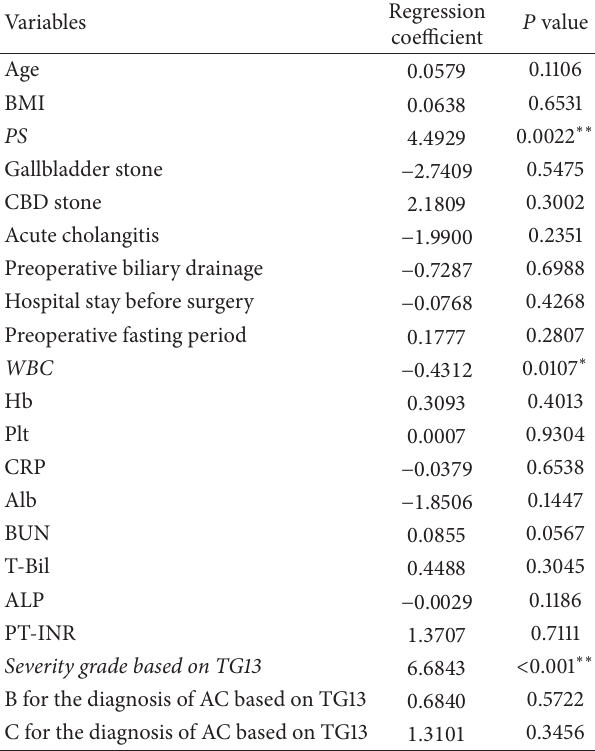
Table 6: Multivariate analyses of the factors influencing MC in the FFS system in the 171 patients who had definite, suspected, or unmatched AC